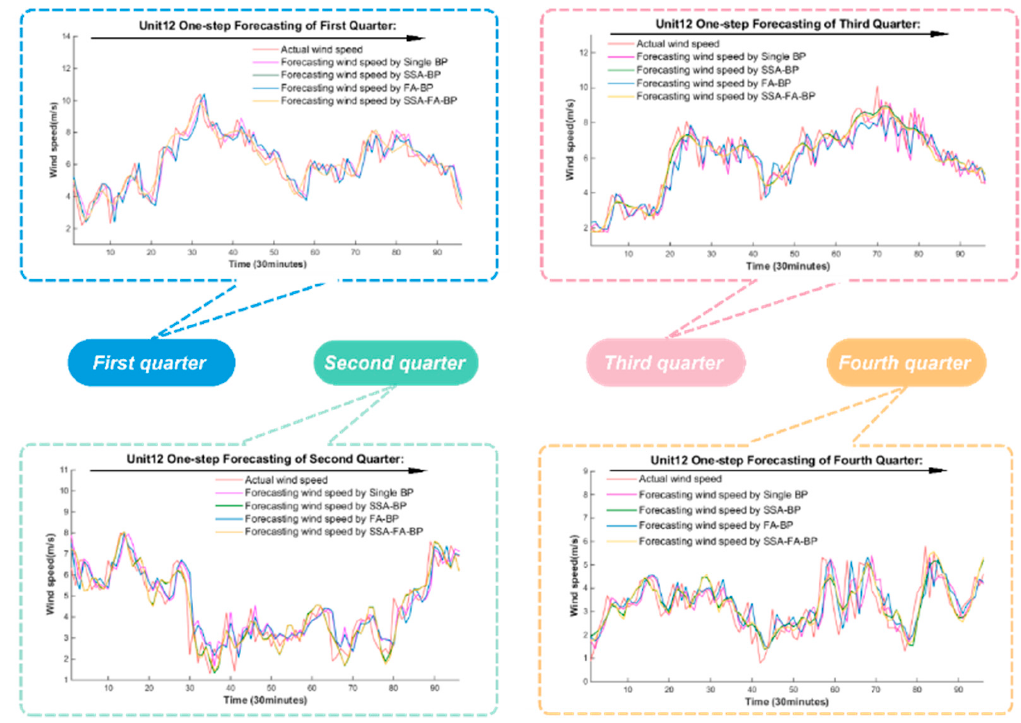
Figure 9. The quarterly forecasting results of the wind series of Unit 12 with one-step (30 min). Table 6. The quarterly forecasting results of the combined model and the results of the other models involving the data of three Units (30 min).